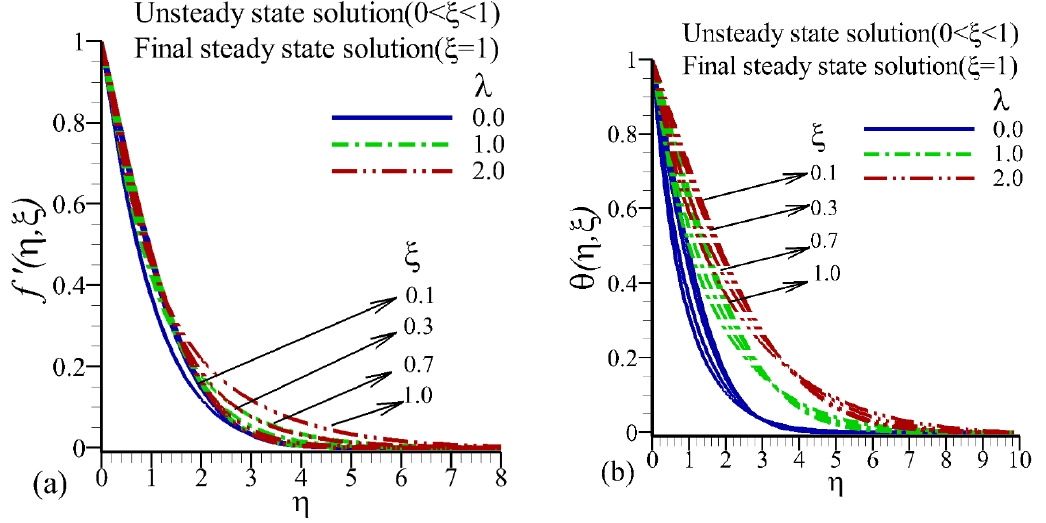
Figure 8. ( a ) Velocity f (cid:48) ( η , ξ ) , ( b ) Temperature θ ( η , ξ ) against η for λ = 0.0,1.0, and 2.0, ξ = 0.1,0.3,0.7,1.0, while R d = M = β = 0.5 and Pr = 1.0.